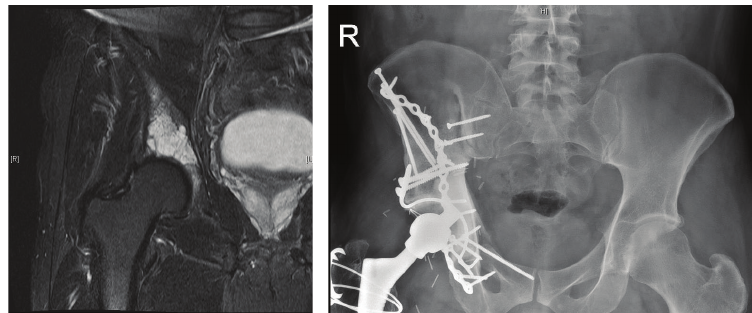
Figure 3: Patient number 4 had poorer functional outcome (MSTS 57). This may be accounted for by the higher level iliac resection and more extensive stripping of the abductor